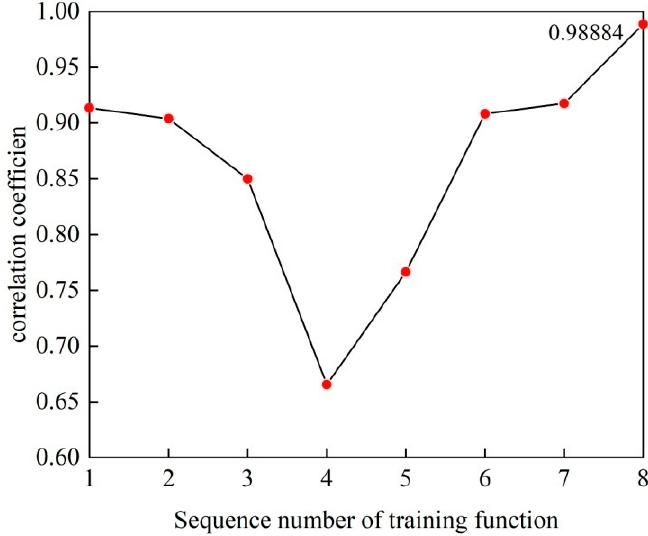
Figure 8. Correlation coefficients of different training function.